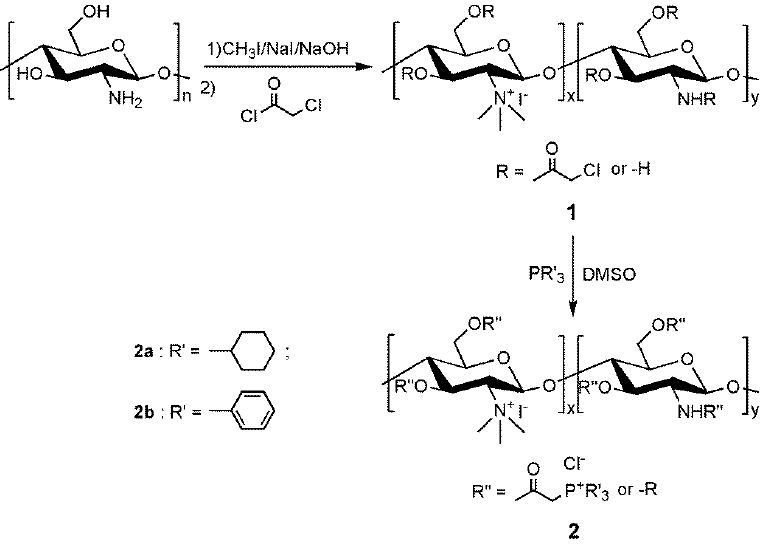
(Figure 2) spectra of chitosan and chitosan derivatives and 31 P-NMR (Figure 3) spectra of the chitosan derivatives were recorded. Molecules 2017 , 22 , 1438